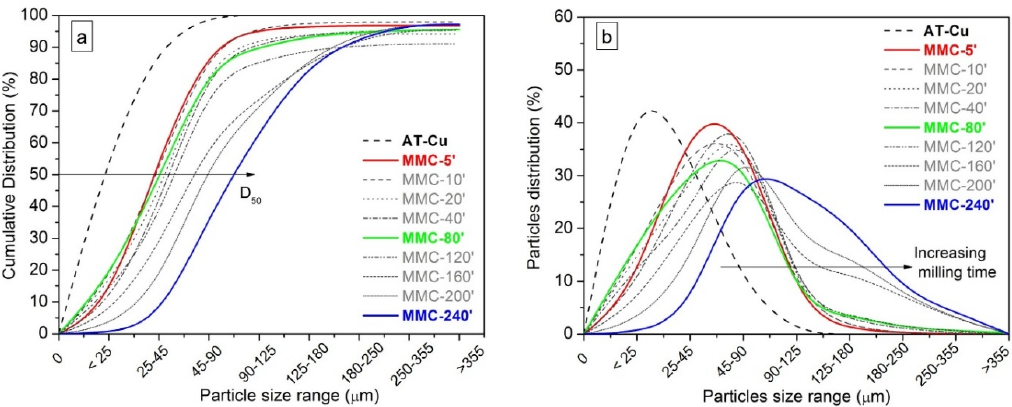
Figure 3. Cumulative distribution ( a ) and particle distribution ( b ) of metal matrix composites (MMC) powder as a function of milling time.